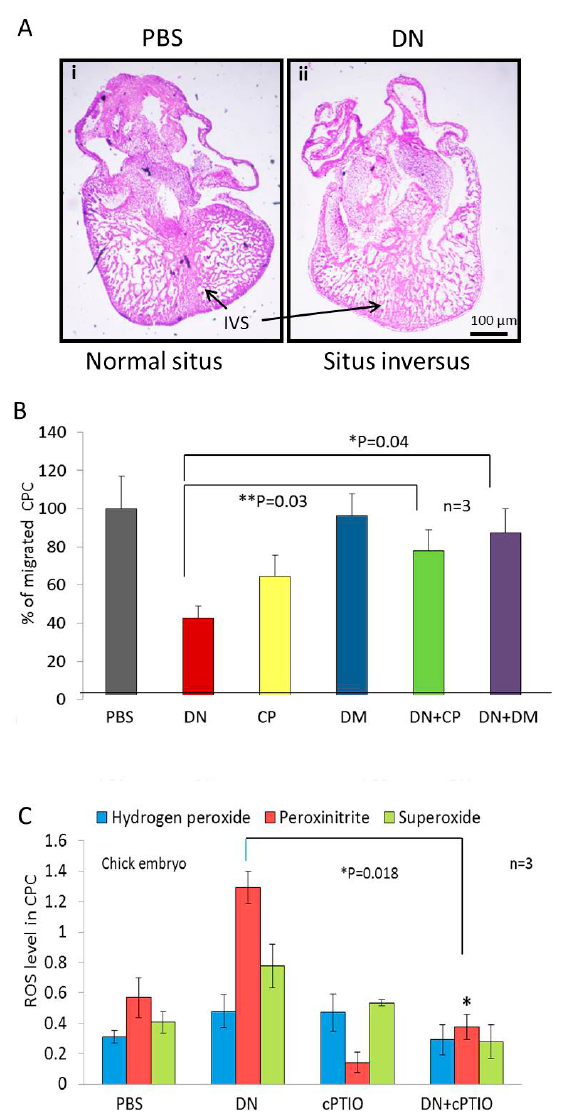
Figure 2. NO mediated migration of CPC migration and oxidative stress. ( A ) Vertical sections of 4th day old chick embryonic heart stained with H&E, arrows indicate intraventricular septum (IVS). (i) PBS treated embryonic heart section showing the prominent interventricular septum and ventricular polarity indicated by black arrows. (ii) Heart section of DN treated embryo showing loss of interventricular septum and ventricular polarity. ( B ) Boyden chamber analysis of CPC migration under PBS or DN or CP or Dorsomorphin (DM) or DN + CP or DN + DM. ( n = 3, * p = 0.04 DN vs. DN + DM, ** p = 0.03 DN vs. DN + CP, by one-way ANOVA). ( C ) The cardiac progenitor cells (CPC) were isolated from the vascular bed and treated with DN or CP or DN + CP. Free radicals which are the main components of ROS machinery such as hydrogen peroxide, peroxynitrite and superoxide were measured from the CPC using Amplex red, dihydrorhodamine and nitro blue tetrazolium assays. ( n = 10, * p < 0.05 vs. DN by one-way ANOVA, n = 3